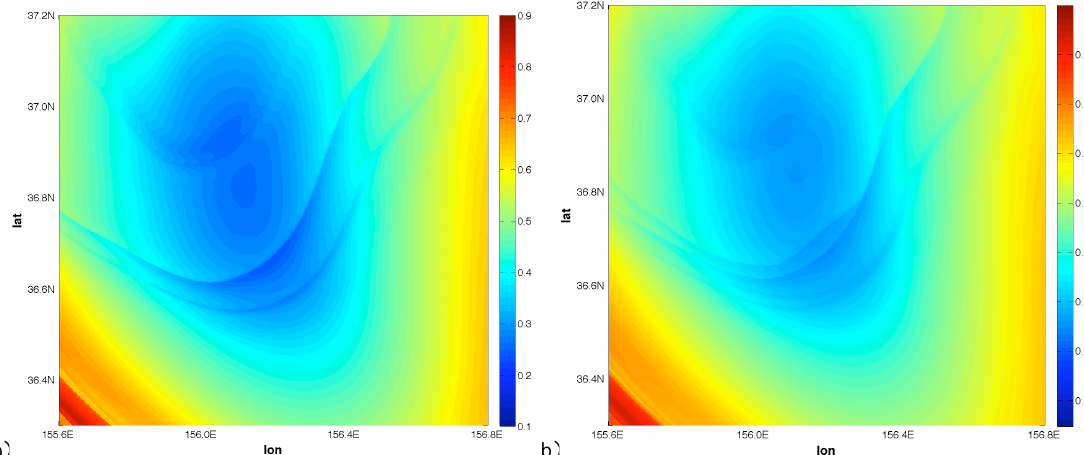
Fig. 8. Contour plot of the function M over the inner part of an eddy on 2 May 2003 for τ = 30 days (a) results with bicubic spatial interpolation; (b) results with bilinear spatial